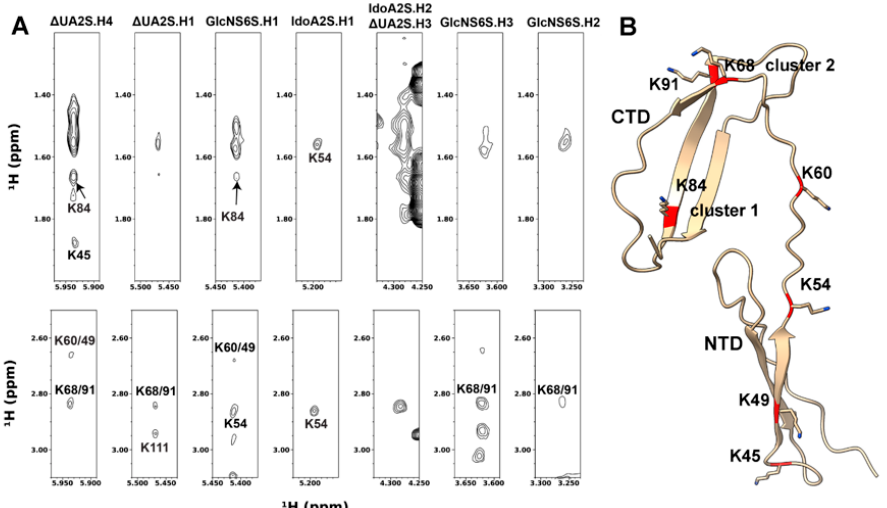
Figure 4. Intermolecular NOE between PTN and DP6-C seen in the 2D homonuclear NOESY of 0.2 mM 2 H-labeled PTN with 1 H-labeled lysines in the presence of 0.9 mM DP6-C. ( A ) Strips from the 2D- NOESY spectrum showing intermolecular contacts between PTN and DP6-C. ( B ) Ribbon representa- tion of PTN with the residues involved in intermolecular contacts colored in red. representation of PTN with the residues involved in intermolecular contacts colored in